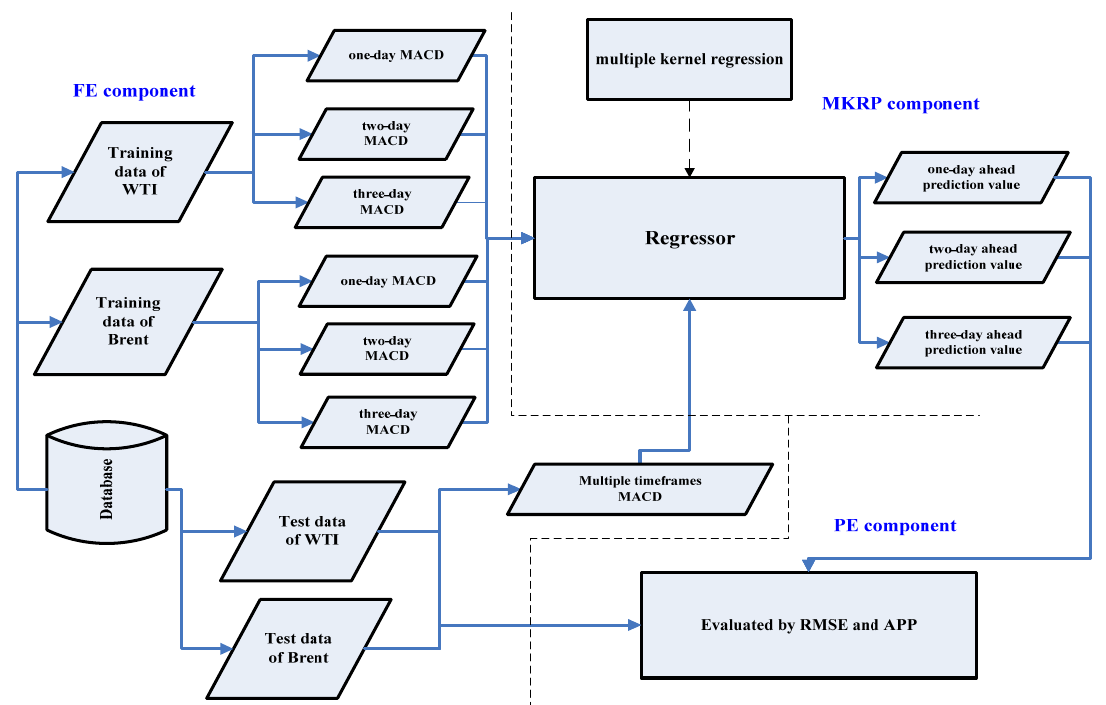
Figure 1. Structure of proposed